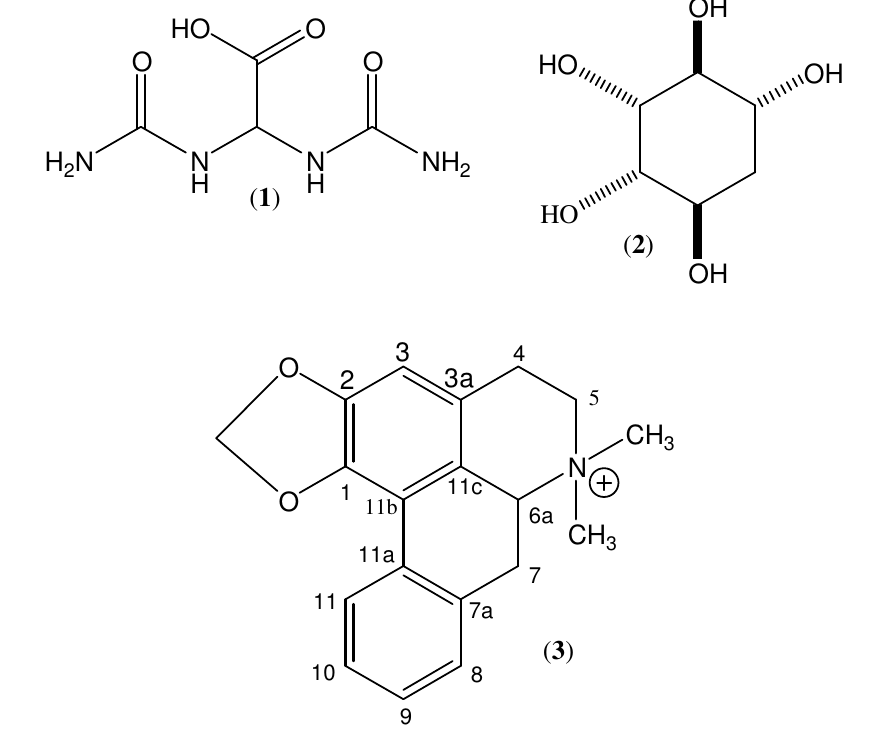
Figure 1. Chemical structures of allantoic acid ( 1 ), proto-quercitol ( 2 ), and roemrefidine ( 3